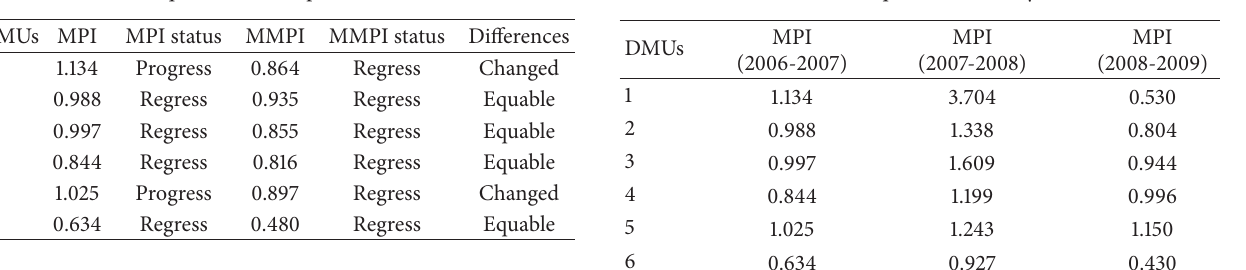
Table 6: Malmquist index comparison of 2007 to 2006.